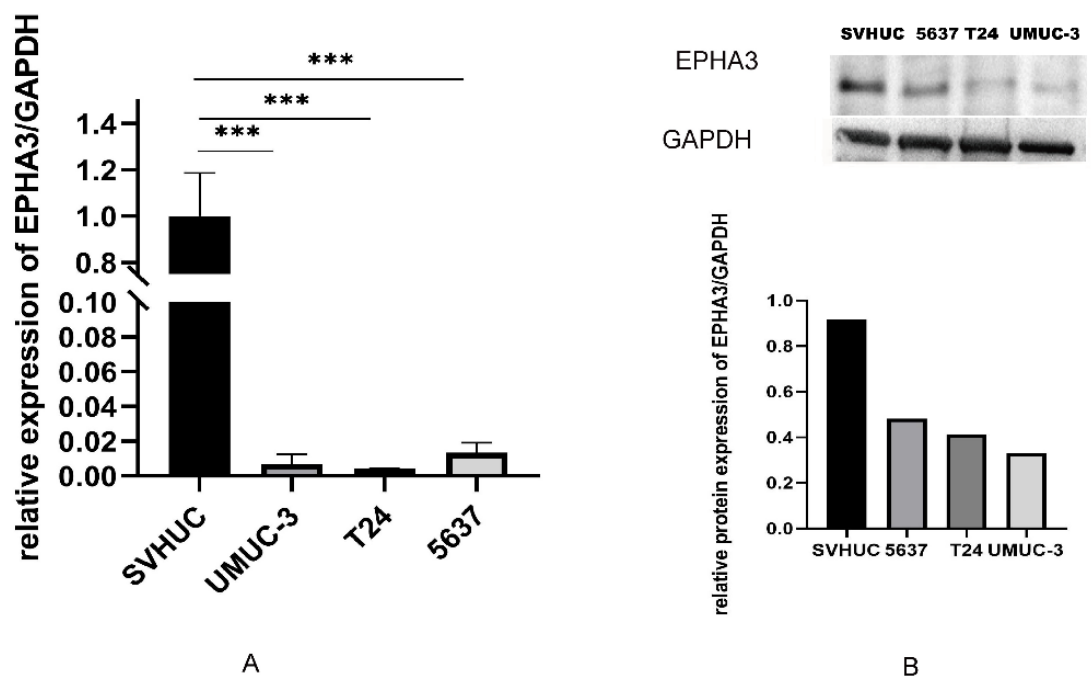
Figure 9. The EPHA3 levels different cells. ( A ) RT-qPCR on EPHA3 levels within SVHUC, T24, UMUC-3, and 5637 cells. ( B ) Western blotting of EPHA3 within the above three cell lines. *** p < 0.001.